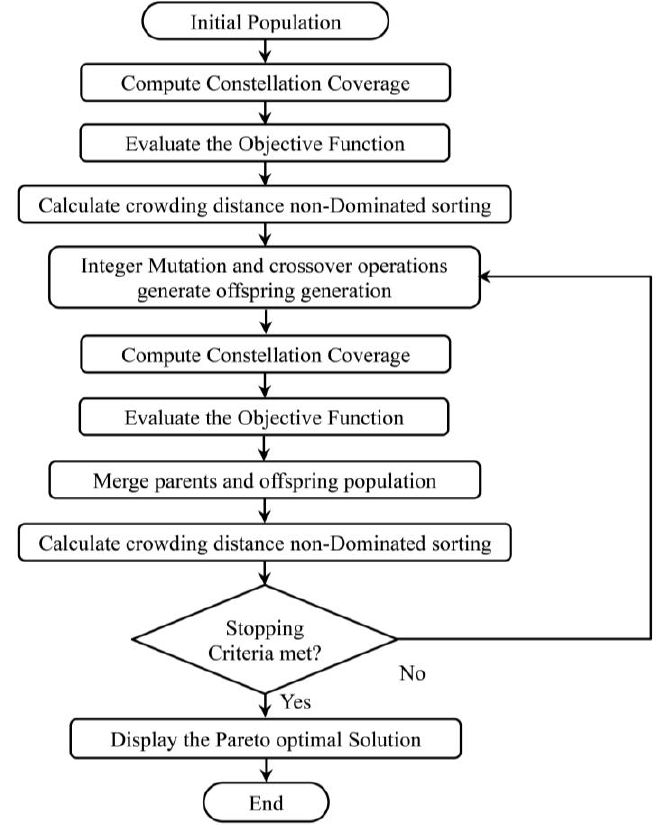
Figure 4. Overall system flow chart for simulation.